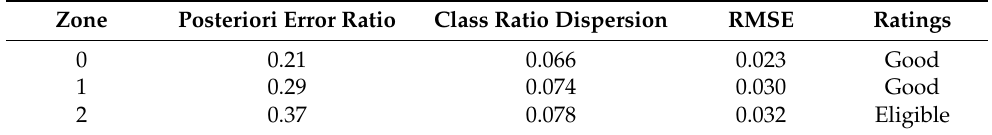
Table 6. Prediction accuracy of the grey model.